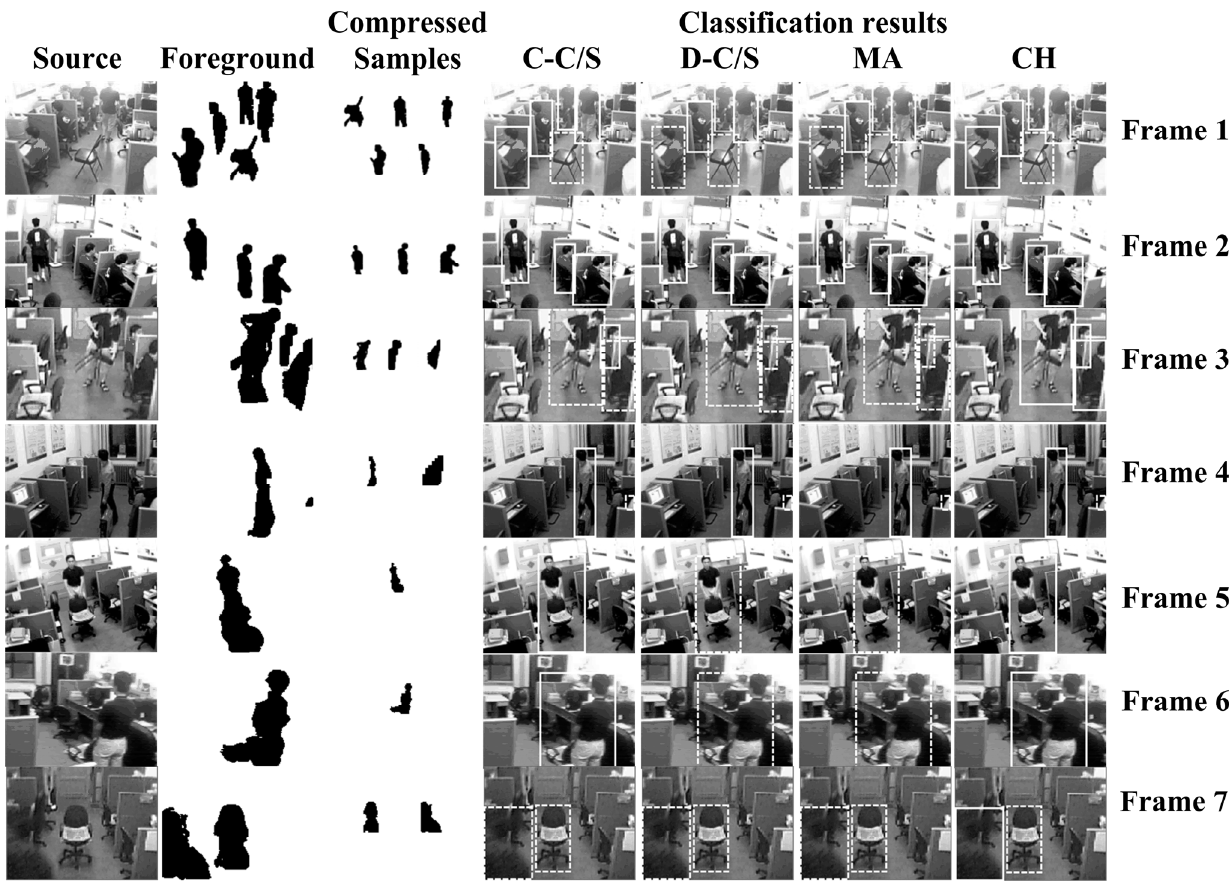
Figure 14. Selected frames of target classification results in different sensor